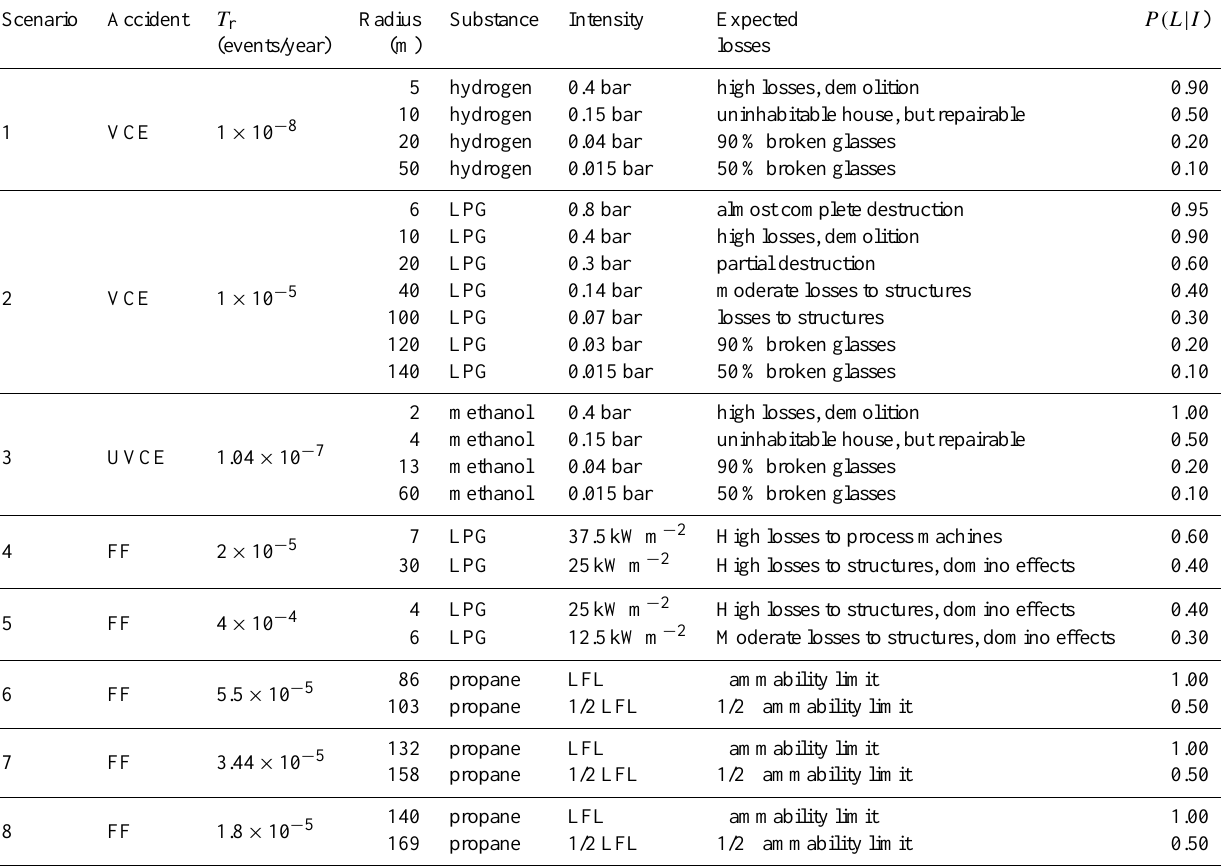
Table 7. Vulnerability, P(L | I ) to industrial risk as from safety plans.